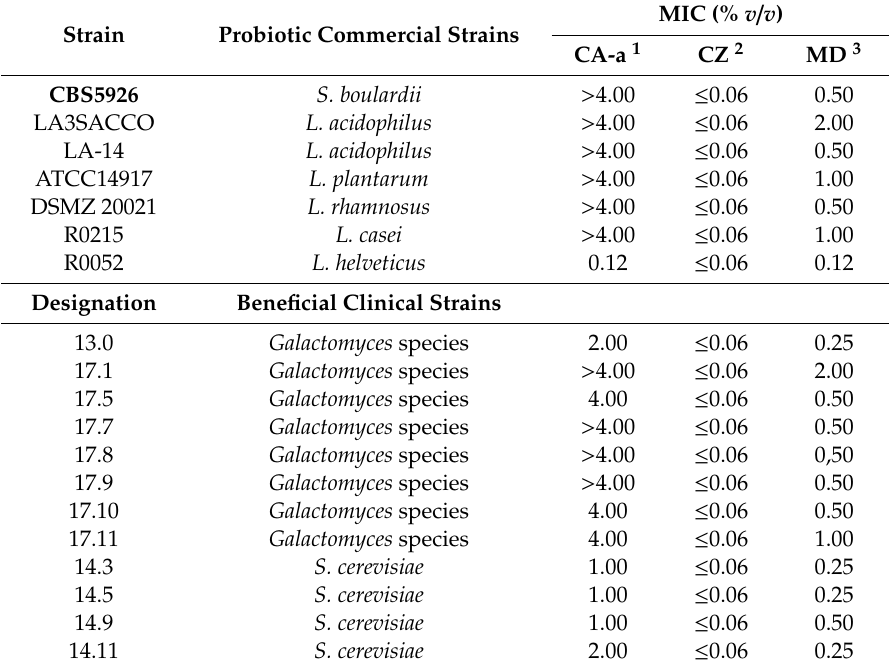
Table 2. MIC values of commercial probiotic strains and clinical beneficial bacterial strains against the essential oils of M. dydima, C. aurantium var. amara , C. zeylanicum . Strain Probiotic Commercial Strains